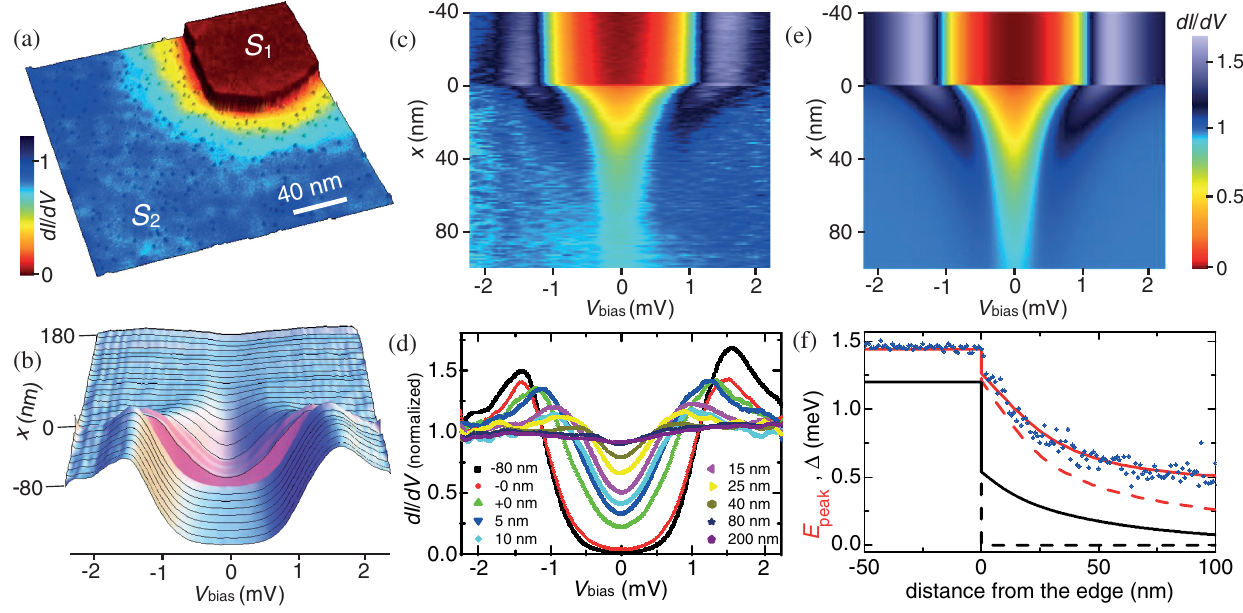
FIG. 3. The same as in Fig. 3, but for T ¼ 2 . 05 K. At this temperature, the striped incommensurate Pb monolayer S 2 is in its normal state. Notice that the order parameter determined self-consistently exhibits a finite value close to the S 1 - S 2